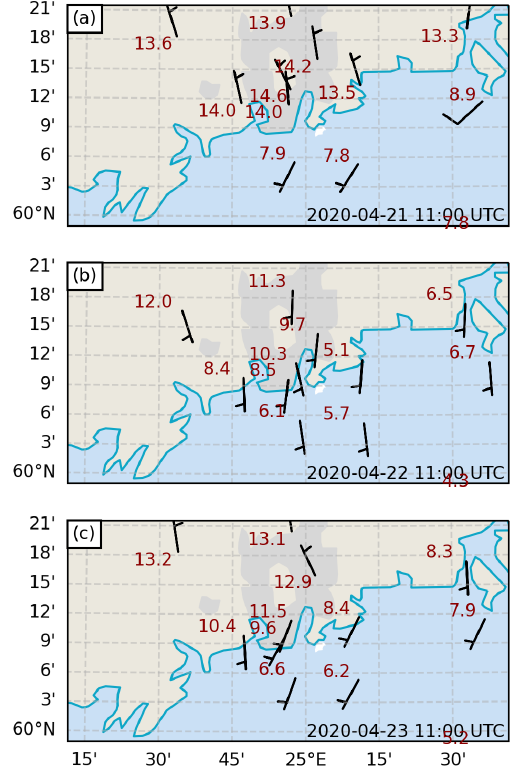
Figure 11. Surface observations of temperature and wind from offi- cial weather stations close to Helsinki at 11:00UTC on (a) 21